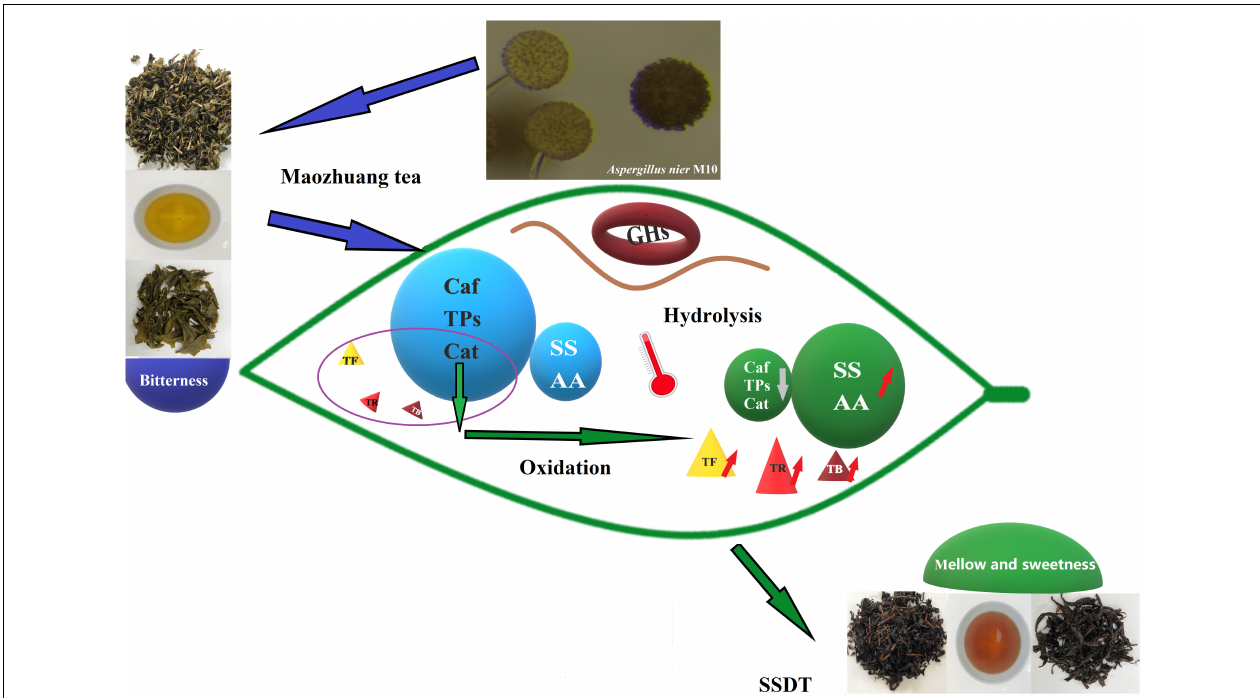
FIGURE 5 | A schematic diagram summarizing the specifics of Aspergillus nier M10 mediating SSDT taste and color quality. Changes in the main indicators of taste and color are listed. Orange arrows represent increase and gray arrows represent